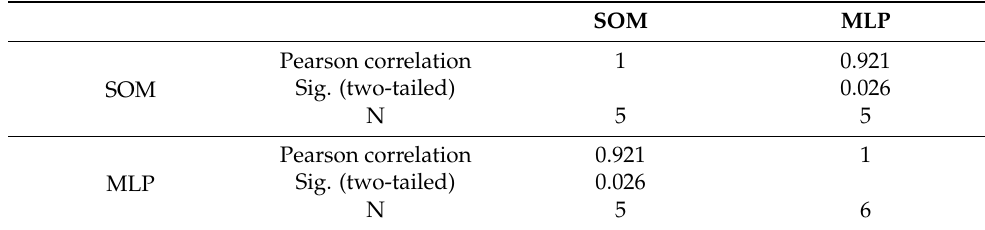
Table 12. Correlation between the MLP and SOM for the least vulnerable zones.